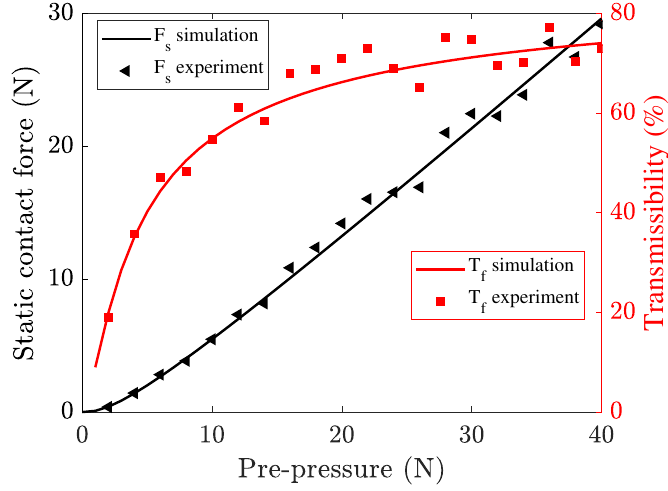
Figure 17. Experimental and simulation results for static contact